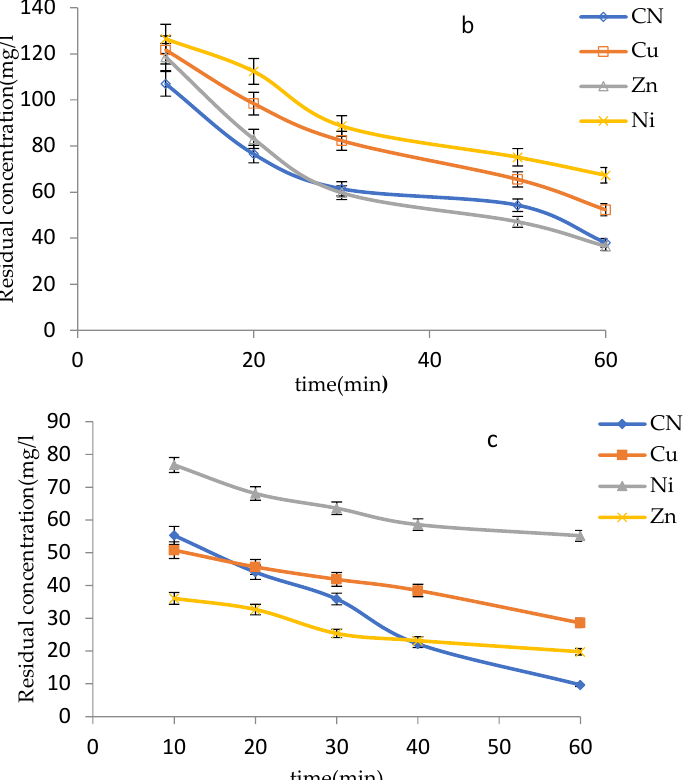
Figure 9. Effect of the applied current intensity at (PEC) CI with a current intensity of: ( a ) 100, ( b ) 200, and ( c ) 300 mA.